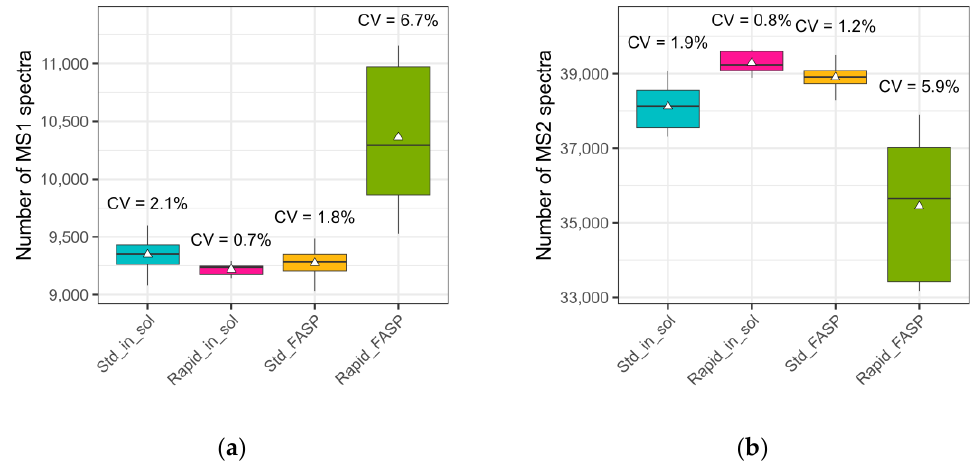
Figure 1. Raw data quality assessment: number of MS1 and MS2 spectra. CSF samples were digested using different approaches: Std_in_sol — standard in-solution digestion; Rapid_in_sol — rapid in-so- lution digestion; Std_FASP — standard filter-aided preparation; Rapid_FASP — rapid filter-aided preparation. Some 500 ng of the respective digestions were measured with nanoLC-MS and the acquired data were analyzed using our in-house developed quality control tool MaCProQC . ( a ) the number of precursor spectra and ( b ) number of fragment spectra as well as the coefficient of varia- tion (CV) of these between replicates (n = 5) were analyzed. The highest variation in both the number of MS1 and MS2 spectra was observed for the rapid FASP; the lowest one for the rapid in-solution digestion.